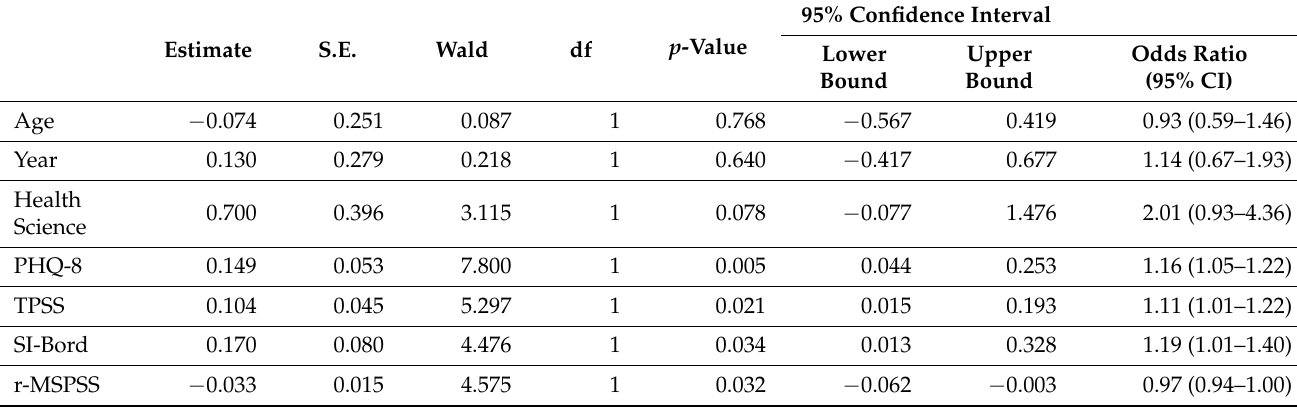
Table 4. Results of multivariable ordinal regression